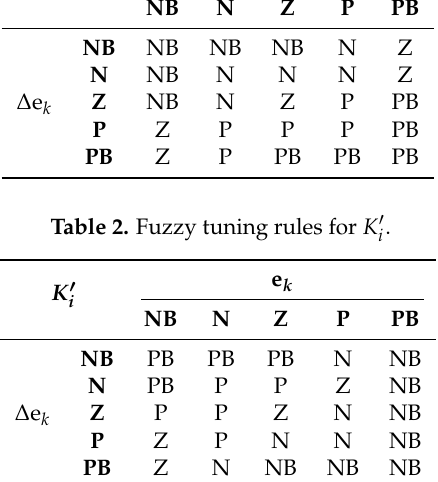
Table 1. Fuzzy tuning rules for K (cid:48) p .